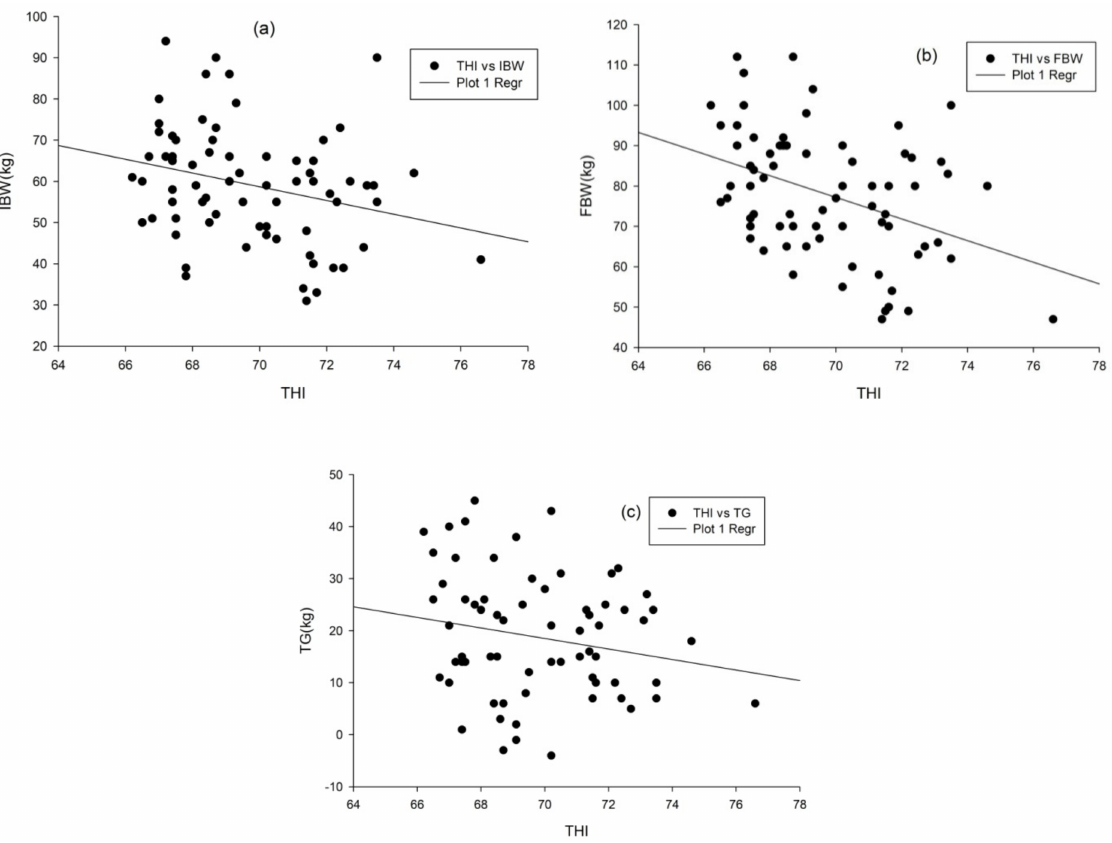
Figure 3. Relationship between THI and IBW ( a ), THI and FBW ( b ), and THI and TG ( c ) THI, IBW, FBW, and TG, are temperature–humidity index, initial body weight, final body weight, and total gain,